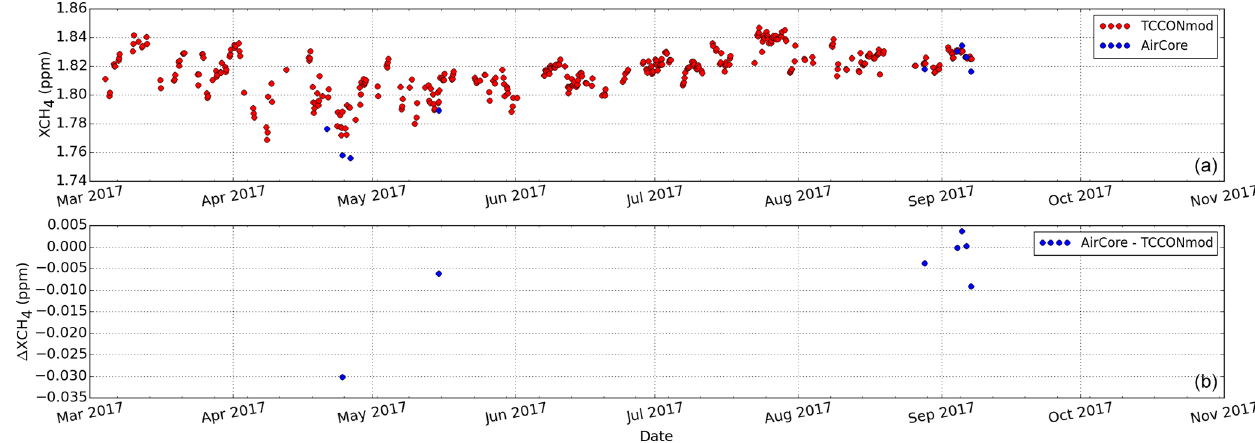
Figure 3. Time series of XCH 4 retrievals using non-linearity-corrected TCCON and AirCore measurements (a) and bias plot in absolute unit (b) plotted for measurements performed in 2017 at SZA < 75 ◦ .